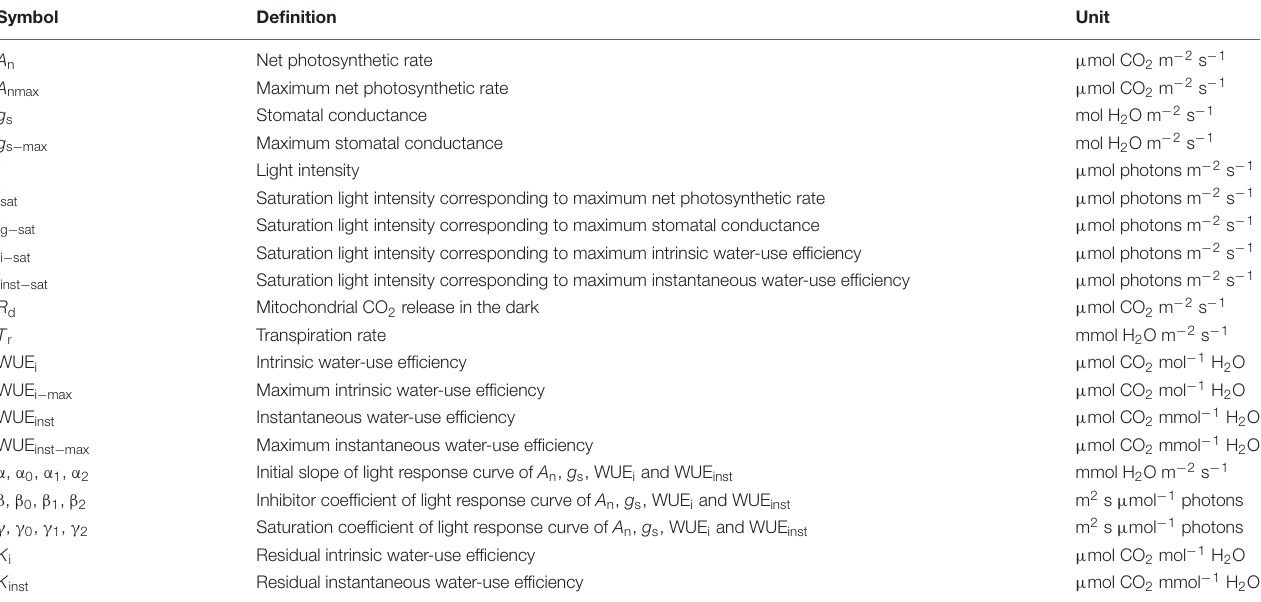
TABLE 1 | List of major model parameters defining the light response curves of photosynthesis ( A n ), stomatal conductance ( g s ), intrinsic water use efficiency (WUE i ), and instantaneous water use efficiency (WUE inst ). Symbol